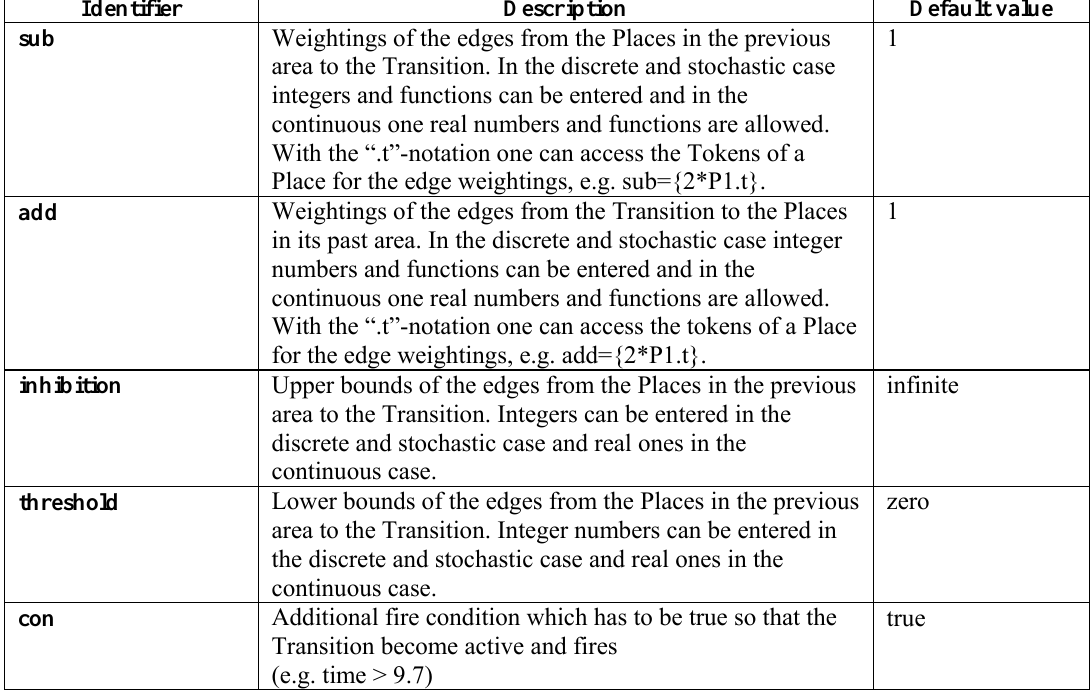
Table 3: Parameters of all Transitions (discrete, stochastic and continuous).